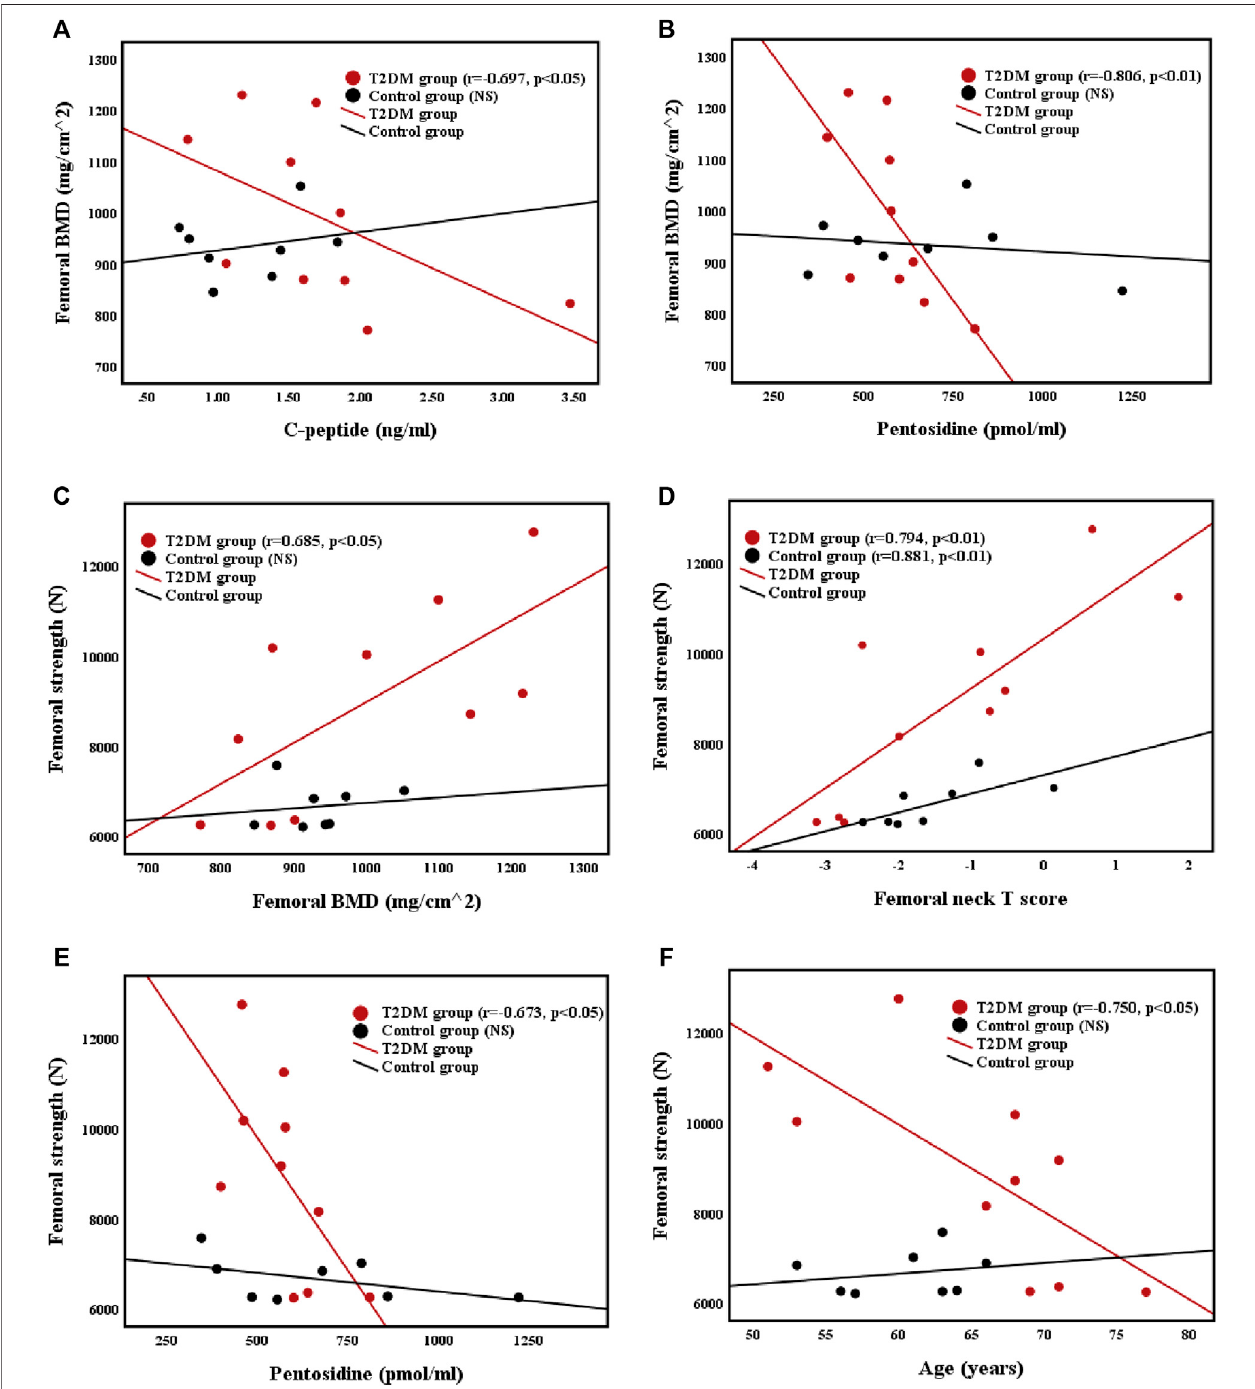
FIGURE 2 | Correlations between (A) femoral BMD and C-peptide level (B) femoral BMD and pentosidine level (C) femoral strength and femoral BMD (D) femoral strength and femoral neck T score (E) femoral strength and pentosidine level, and (F) femoral strength and age in T2DM and control groups.